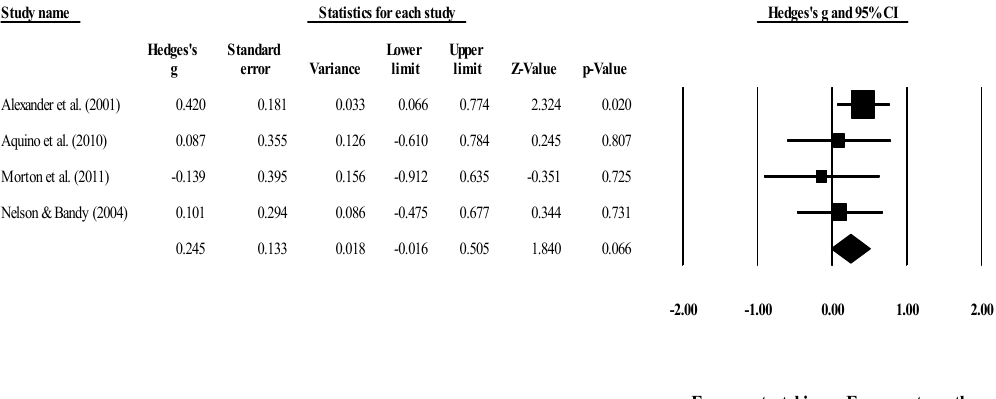
Figure 9. Forest plot of changes in knee extension ROM after participating in stretching-based compared to strength-based training interventions (all assessed passive ROM). Values shown are effect sizes (Hedges’s g) with 95% confidence intervals (CI). The size of the plotted squares reflects the statistical weight of the study.